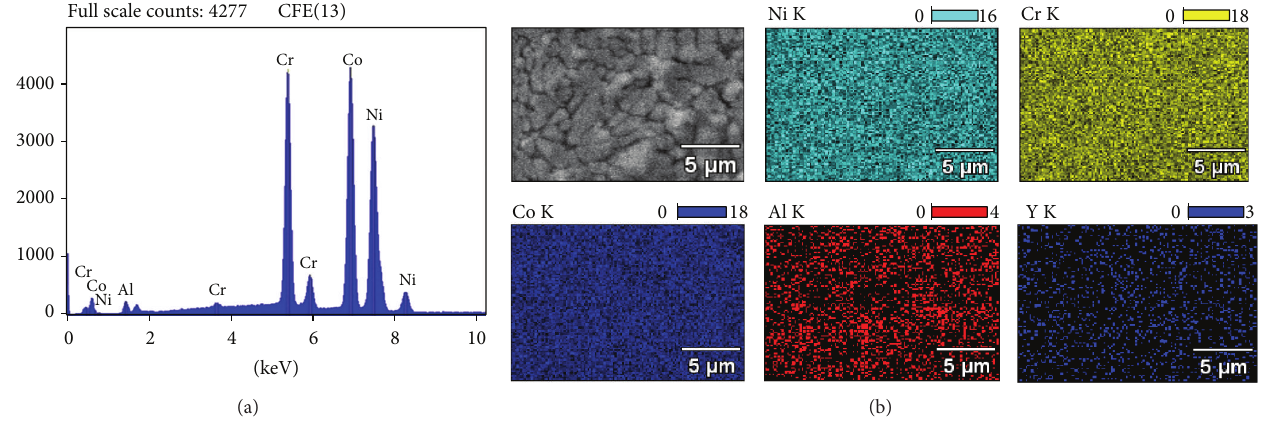
Figure 2: (a) EDS spectrum and (b) EDS elemental mapping of powder particle